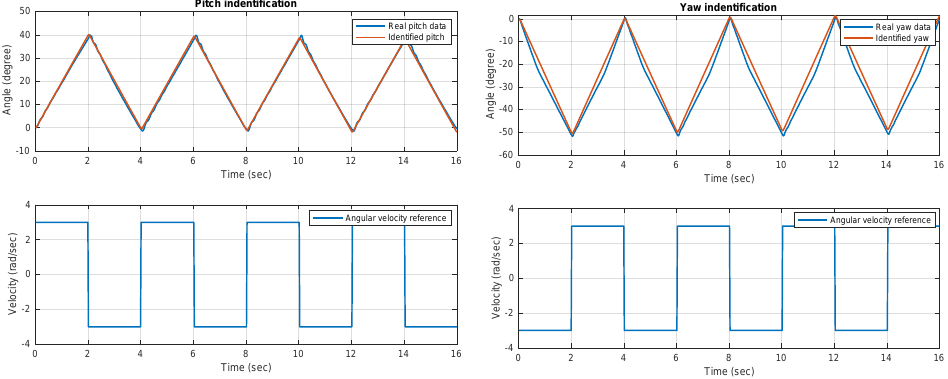
Figure 6. Identification data using motor velocity input and pitch ( left ) and yaw ( right )